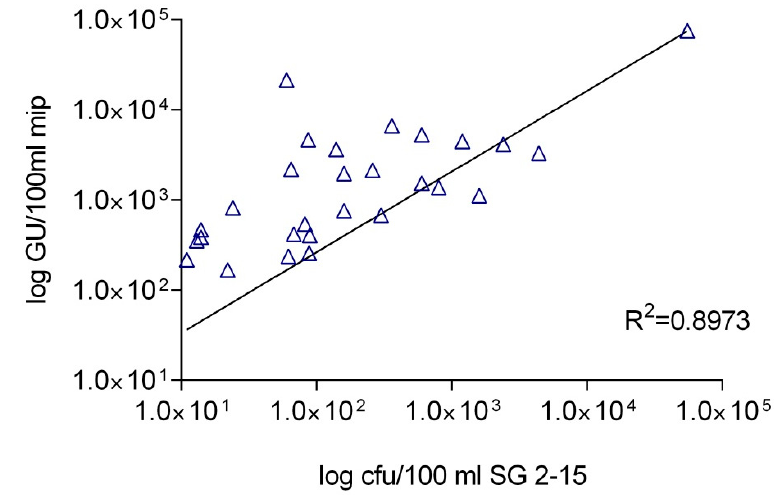
Figure 1. Comparison of L. pneumophila sg2–15 culture and qPCR results ( mip gene) for 83 water samples: Only pairs of results with values positive both in culture and qPCR are shown and used for calculation of the correlation coefficient ( n = 28). The R 2 value of 0.8973 indicates a correlation between culture and qPCR.